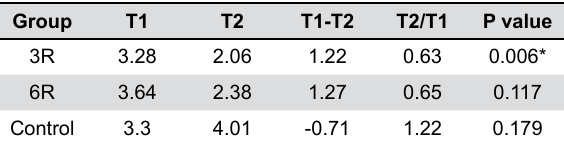
In absolute values, the control group exhibited an increase in the VAS test, as shown by the negative difference between T1 and T2. This finding shows that the patients in the control group did not experience self-perceived improvements in halitosis. The 3R group and the 6R group exhibited similar results in terms of their T2:T1 ratios (0.63 and 0.65, respectively). Student’s paired t-test. *Statistically significant difference; p<0.05